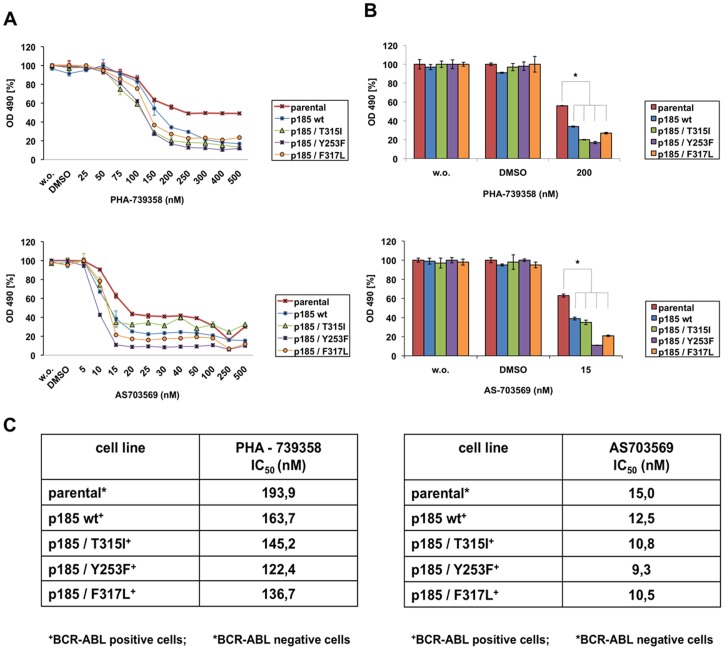
Aurora Kinase inhibitors PHA-739358 and R763/AS703569 compromise cell proliferation and viability at different concentrations in BCR-ABL negative and positive Ba/F3 cells independent of the BCR-ABL mutation status.(A) Dose-effect curves for treatment with the indicated concentrations of PHA-739358 and R763/AS703569 in Ba/F3 and Ba/F3 p185 cells, including the IM-resistant mutants T315I, Y253F and F317L, after 48 h. Effects on cell proliferation were assessed by MTT assay. Shown is one representative experiment of three experiments performed. The percentage of cell growth was normalized to the growth of untreated control cells. (B) Bar graph quantifying cell proliferation after exposure to 200 nM PHA-739358 or 15 nM R763/AS703569 for 48 h. Untreated and DMSO-treated cells were used as controls. Shown is one representative experiment of three experiments performed. Values are expressed as mean of triplicates ± SD. The difference between Ba/F3 p185 wt and BCR-ABL mutants is statistically significant. (C) IC50 values of BCR-ABL positive and negative Ba/F3 cells, calculated from the results after 48 h of incubation with PHA-739358 or R763/AS703569.